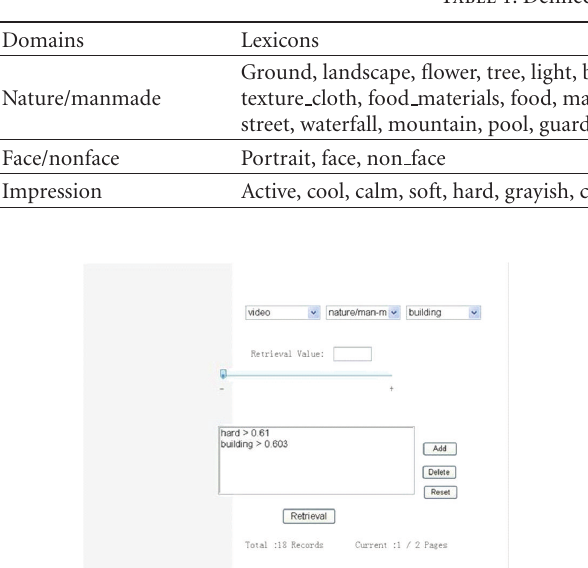
Table 1: Defined domains and lexicons.